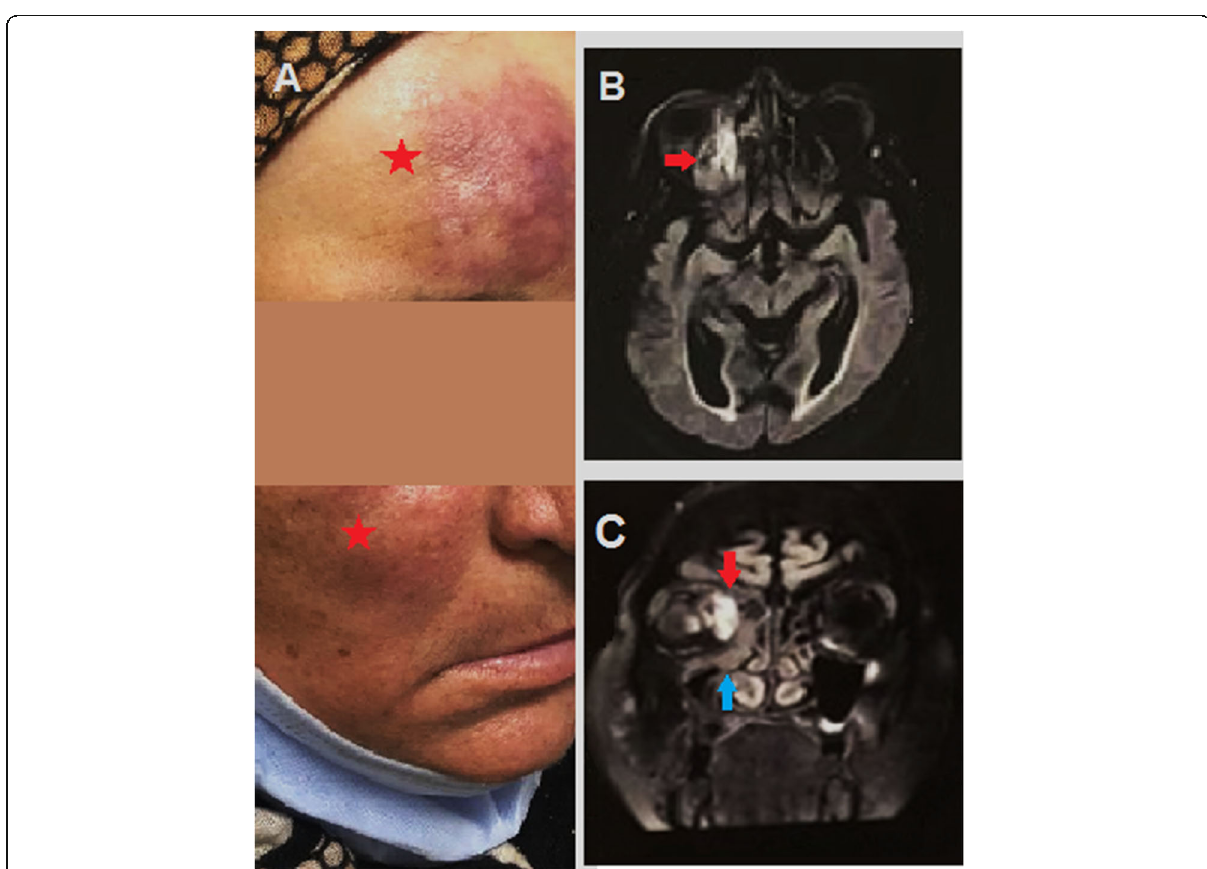
Fig. 1 A Red star highlighting elevated dark colored forehead and right cheek that goes with cutaneous form of mucormycosis. B Red arrow along axial MRI with obliteration of right ostiomeatal complex. C Red arrow along coronal MRI revealing obliteration of right ostiomeatal complex with infiltration of infection to the right orbital cavity. Blue arrow showing maxillary, ethmoid and frontal sinusitis all around the right orbital